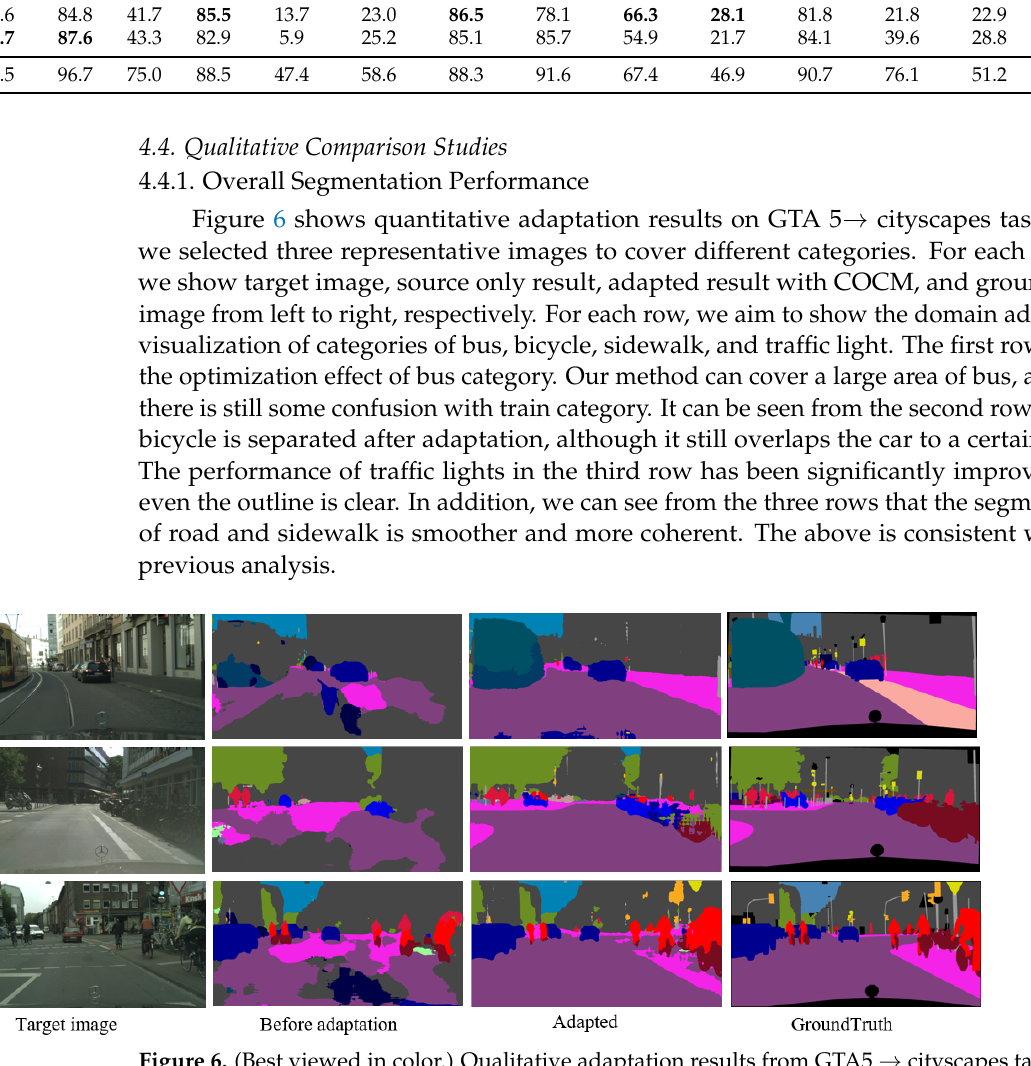
Figure 6. (Best viewed in color.) Qualitative adaptation results from GTA5 → cityscapes